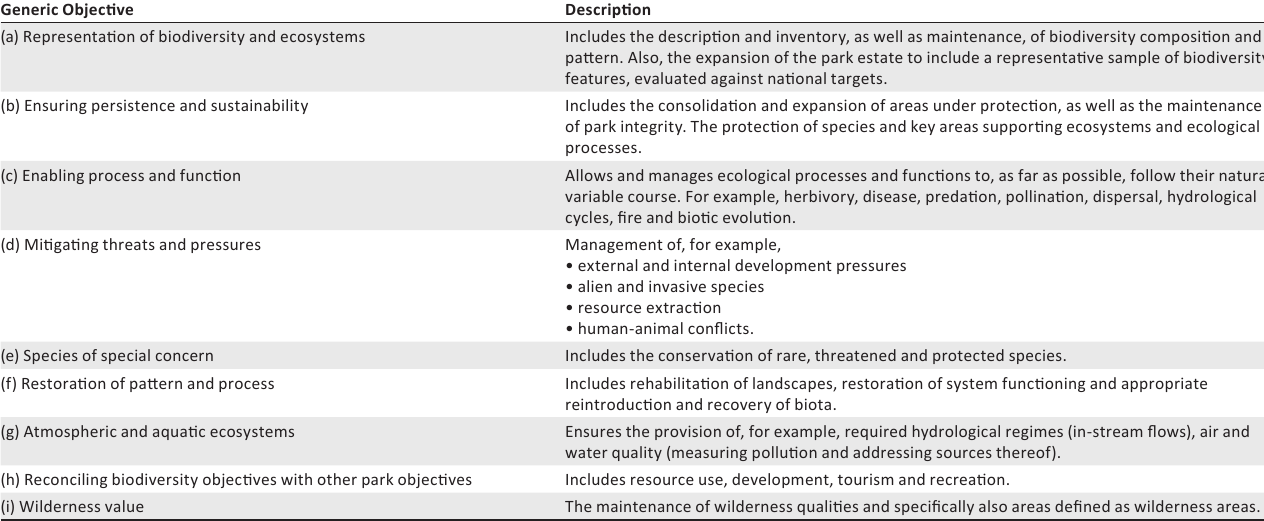
TABLE 1: Current, higher level biodiversity objectives common to Park Management Plans (March 2008) that form the basis for identifying monitoring requirements. Generic